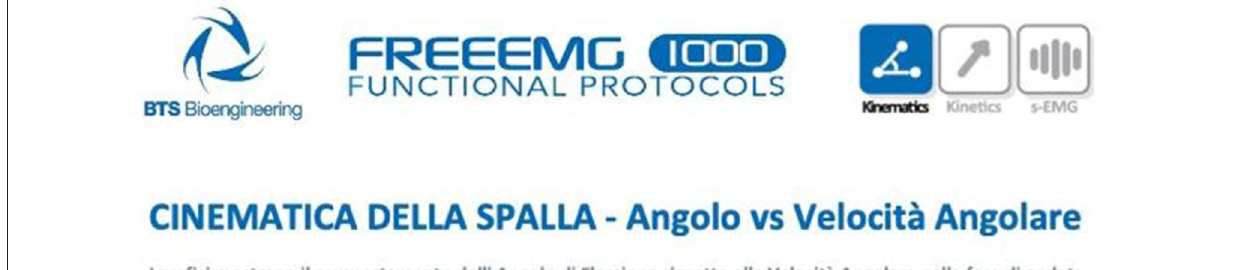
Frontiers in Global Women’s Health | www.frontiersin.org